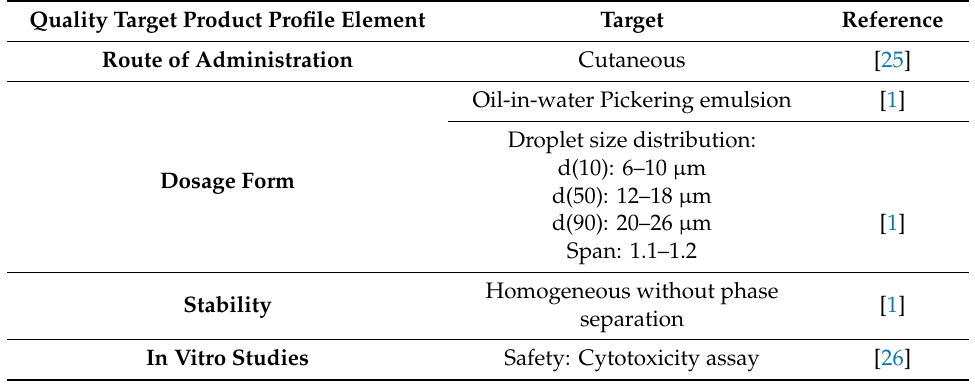
Table 1. Quality target product profile of calcium carbonate (CC)-stabilized